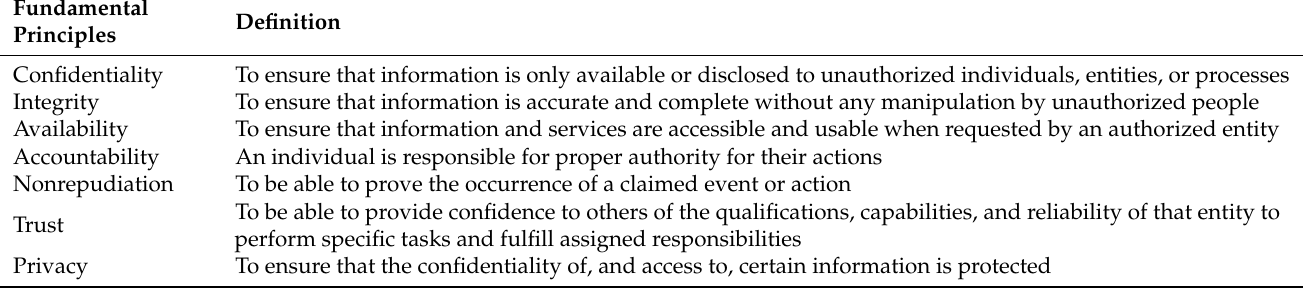
Table 3. Security